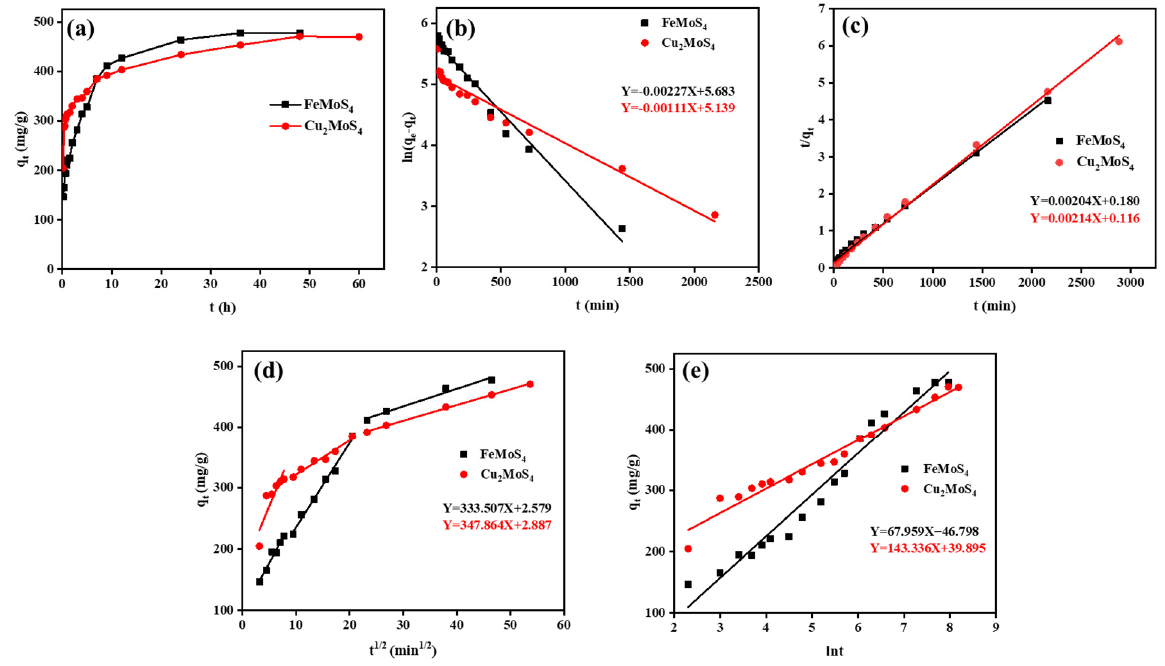
Figure 5. ( a ) Adsorption kinetics and fitting results of ( b ) pseudo-first-order model, ( c ) pseudo-second-order model, ( d ) intra-particle diffusion model, ( e ) Elovich model. (C sorbent = 0.2 g/L, C 0 = 100 mg/L, T = 298 K).